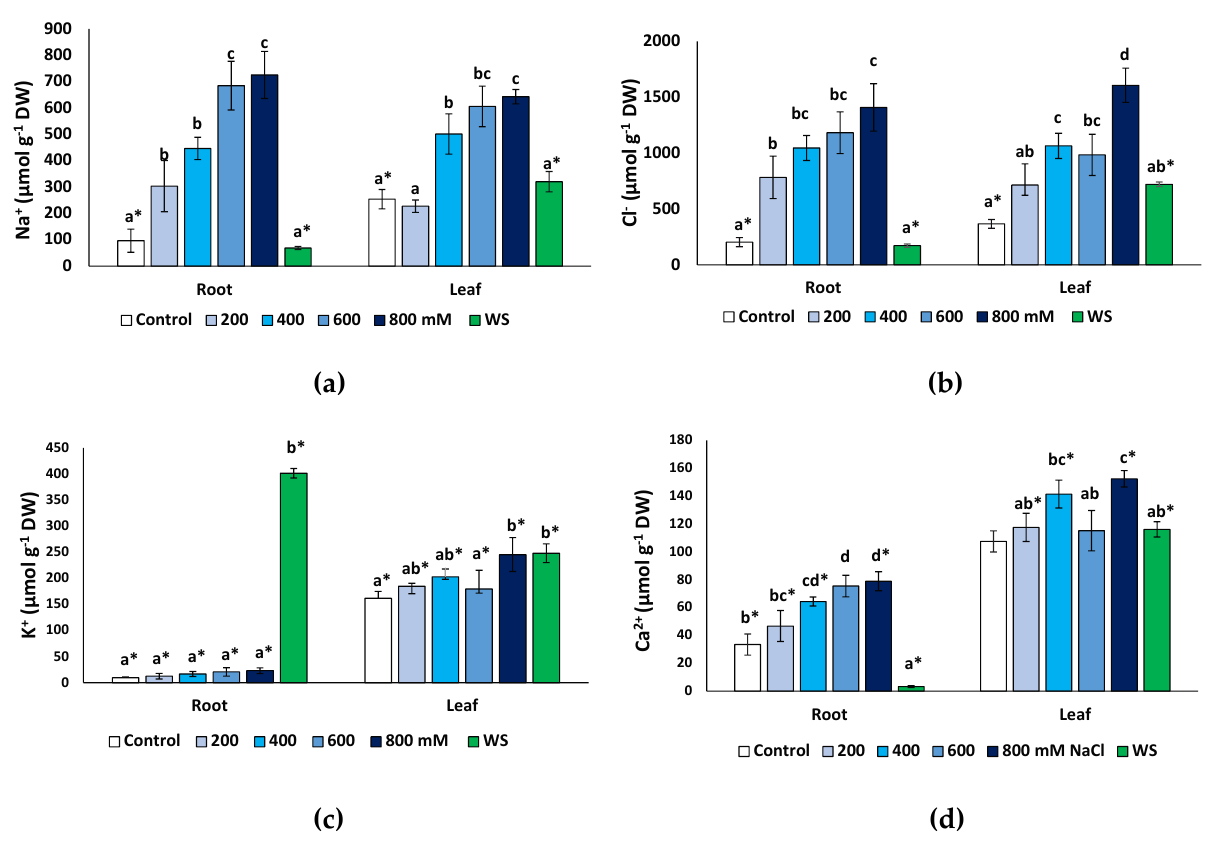
Figure 6. Ion contents in roots and leaves of Limonium angustebracteatum plants after one month of treatment with the indicated NaCl concentrations or one month of water stress (WS). ( a ) Na + , ( b ) Cl − , ( c ) K + , ( d ) Ca 2+ . Means ± SE, n = 6. For each organ, different lowercase letters above the bars indicate significant differences between treatments, according to Tukey’s test ( α = 0.05). Asterisks indicate significant differences between ion concentration values in roots and leaves for the same